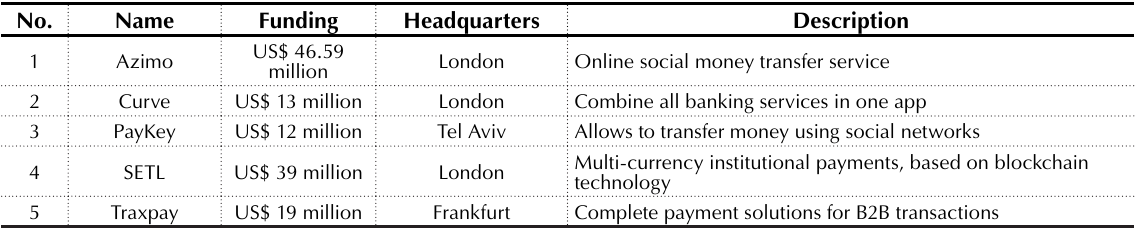
Table 2. New promising European FinTech in